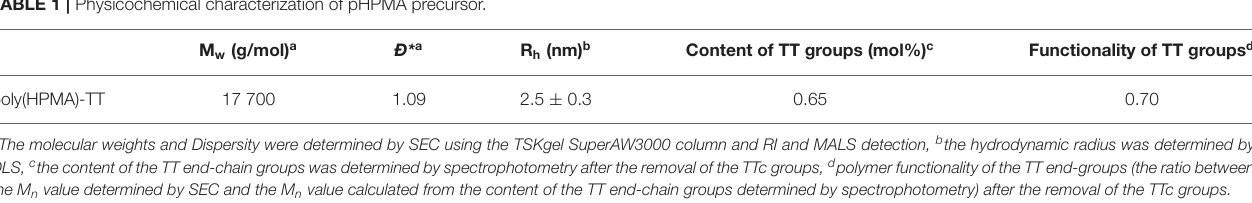
Frontiers in Chemistry |